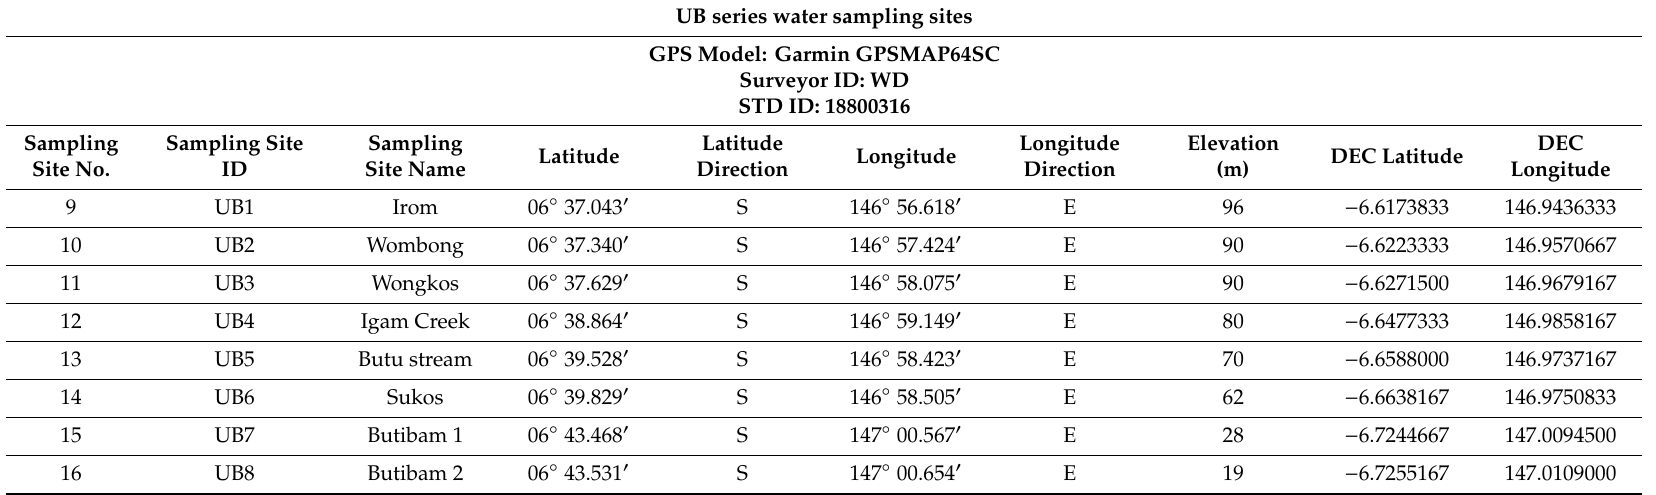
Table A2. GPS survey of the 8 water sampling sites of UB series.